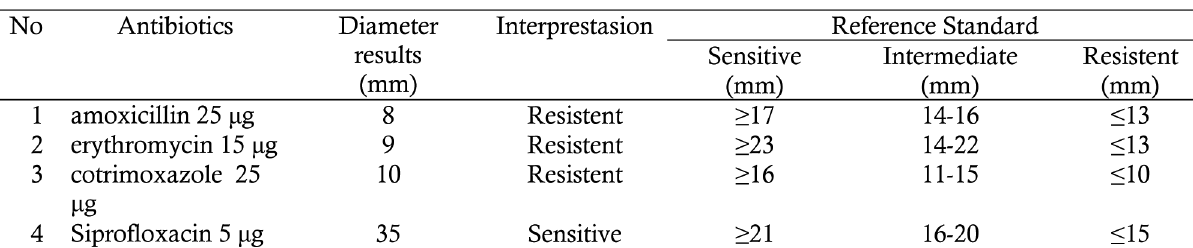
Table 2. Results of uropathogenic E. coli sensitivity test along with a reference standards (EUCAST 2015 and